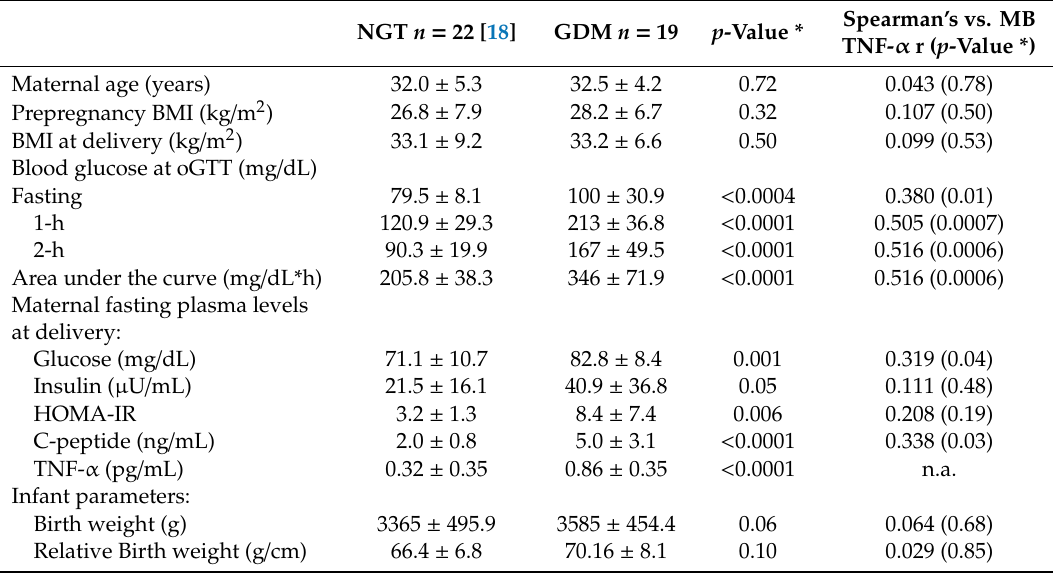
Table 1. General and specific cohort characteristics according to groups, gestational diabetes mellitus (GDM) and normal glucose tolerance (NGT) [18], and relations with maternal blood tumor necrosis factor alpha (TNF- α ) at